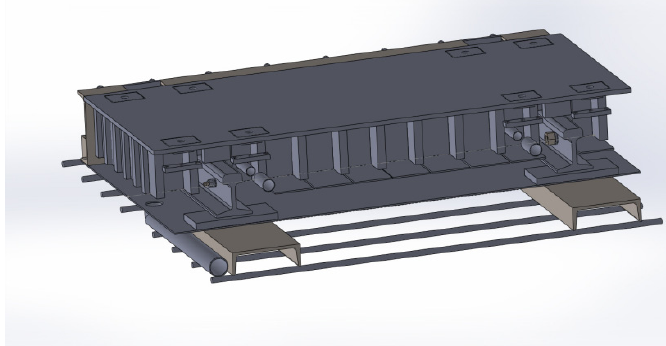
Figure 3. Schematic diagram of the scale structure.